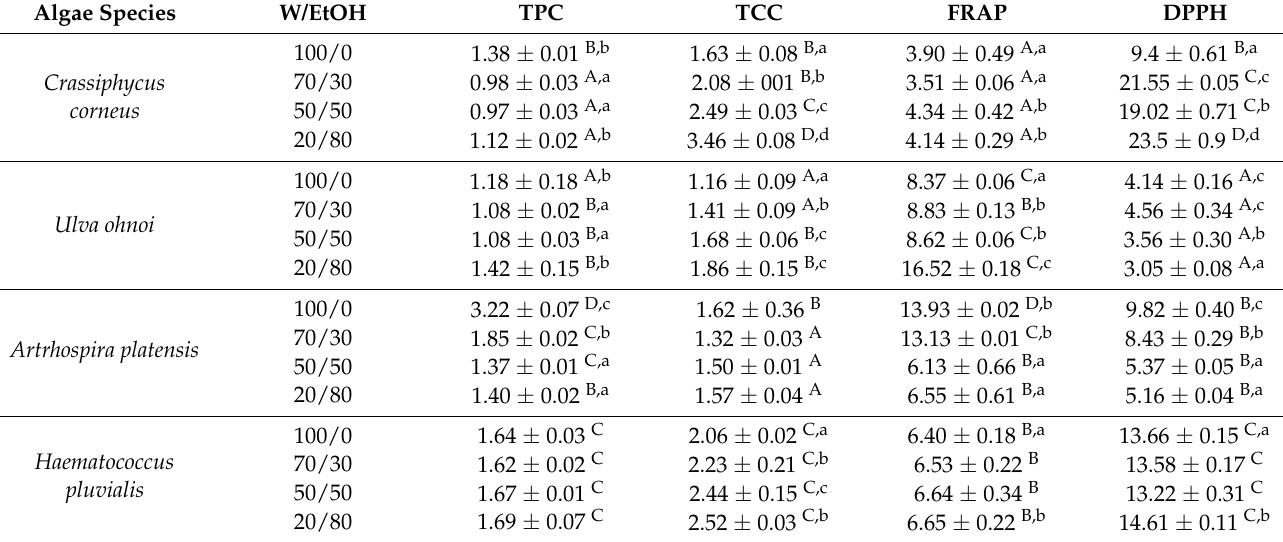
Table 1. Total phenolic and carotenoid contents and antioxidant activity of algae extracts prepared with different water to ethanol